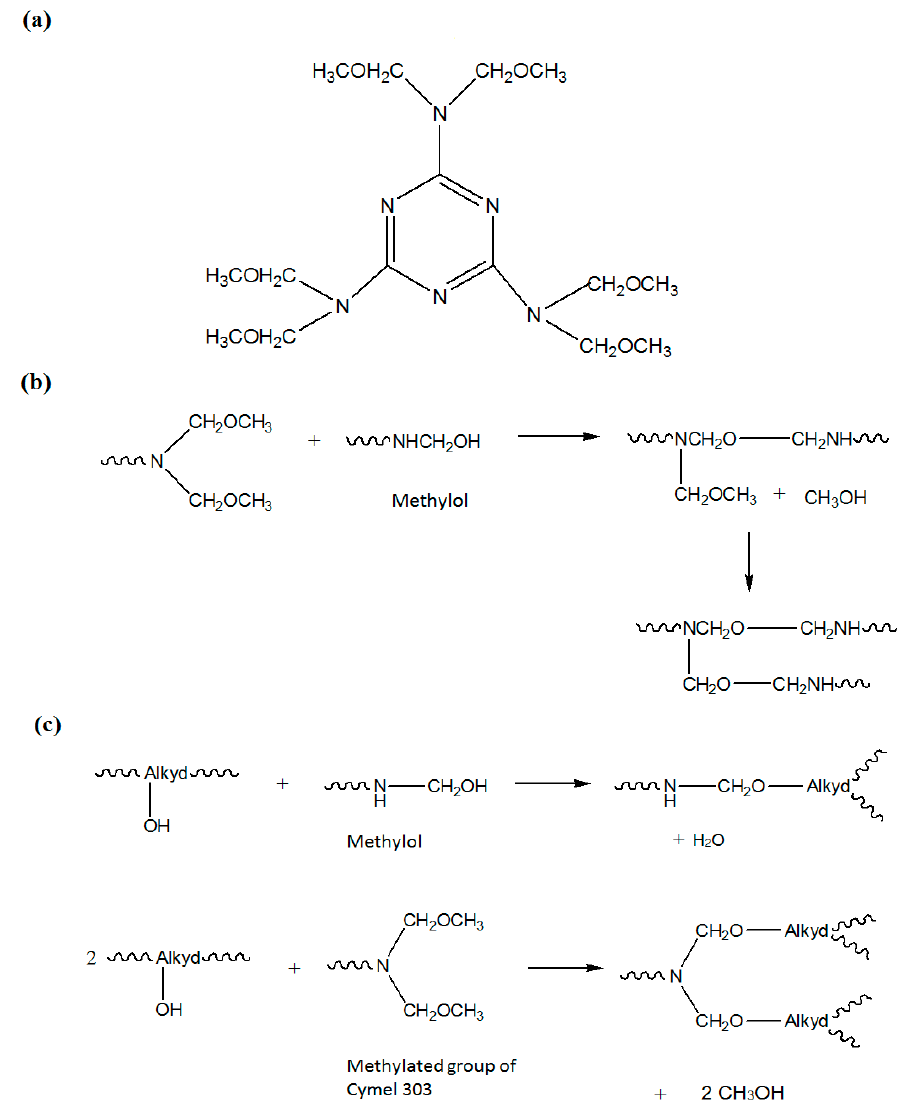
Figure 5. ( a ) Chemical structure of melamine resin (Cymel 303 ® ); ( b ) Plausible reaction of melamine